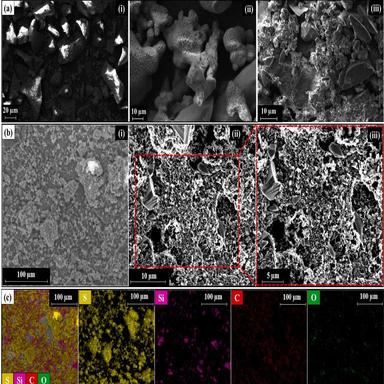
(a) SEM images of the (i) SiOC powder, (ii) commercial sulfur powder, and (iii) S-SiOC composite powder. (b) SEM images of the S-SiOC electrode coated on aluminum foil under different magnifications, as displayed by the scale bars with (i) 100 μm, (ii) 10 μm, and (iii) 5 μm. (c) Elemental mapping of the S-SiOC composite electrode, confirming the presence of sulfur in the structure of the composite electrode.